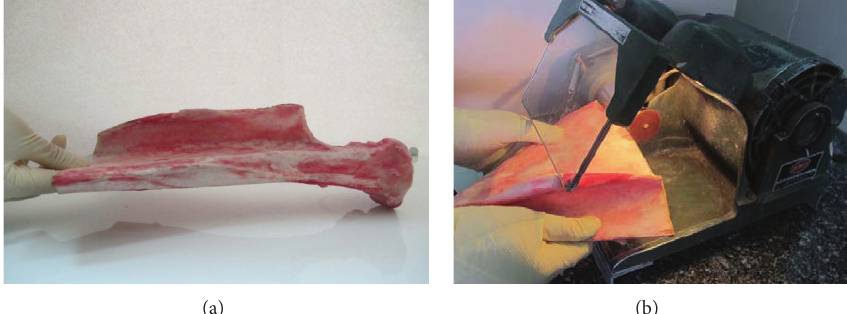
Figure 1: Bovine scapula. (a) Ventral surface. (b) The flat part is separated by dental disc and cutting Lathe motor machine.